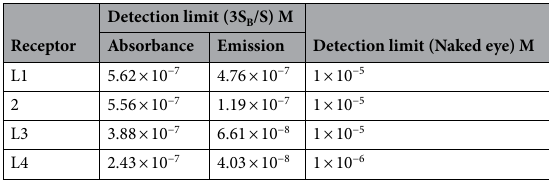
Table 2. Detection limit of receptor L1-L4 with nickel.